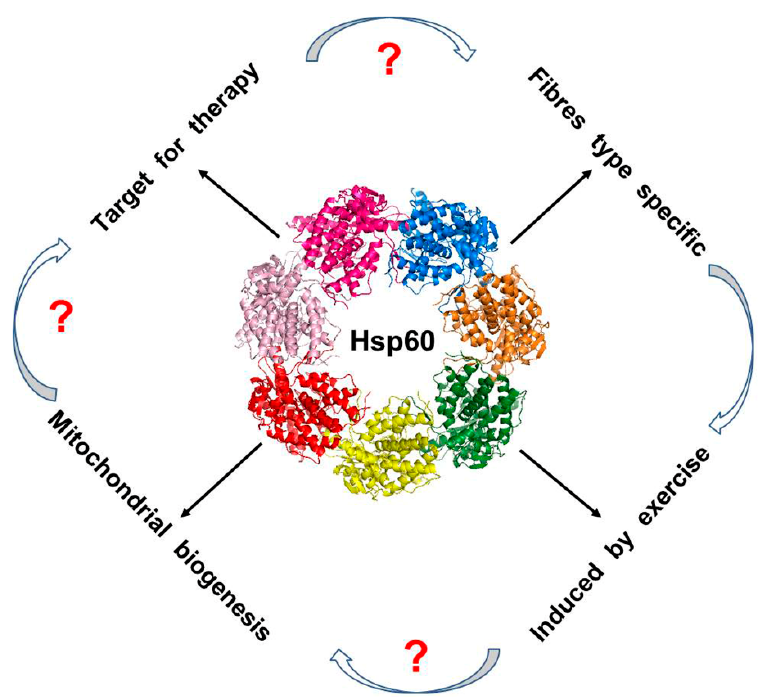
Figure 3. Hsp60 involvement in skeletal muscle homeostasis: working hypothesis. The direct implication of Hsp60 in the maintenance of skeletal muscle biogenesis and homeostasis has been proven by a number of papers, as reported in the text. Moreover, it seems plausible that the chaperonin might have a role in the pathogenesis of some skeletal muscle diseases. As shown in the picture, some questions remains open regarding the direct involvement in the mitochondrial biogenesis, and the meaning of its induction during exercise, as well as possible implications in some skeletal muscle diseases. In the figure a tridimensional model of Hsp60 in which each monomer is differentially colored is shown. The model was created using SWISS-MODEL [112].